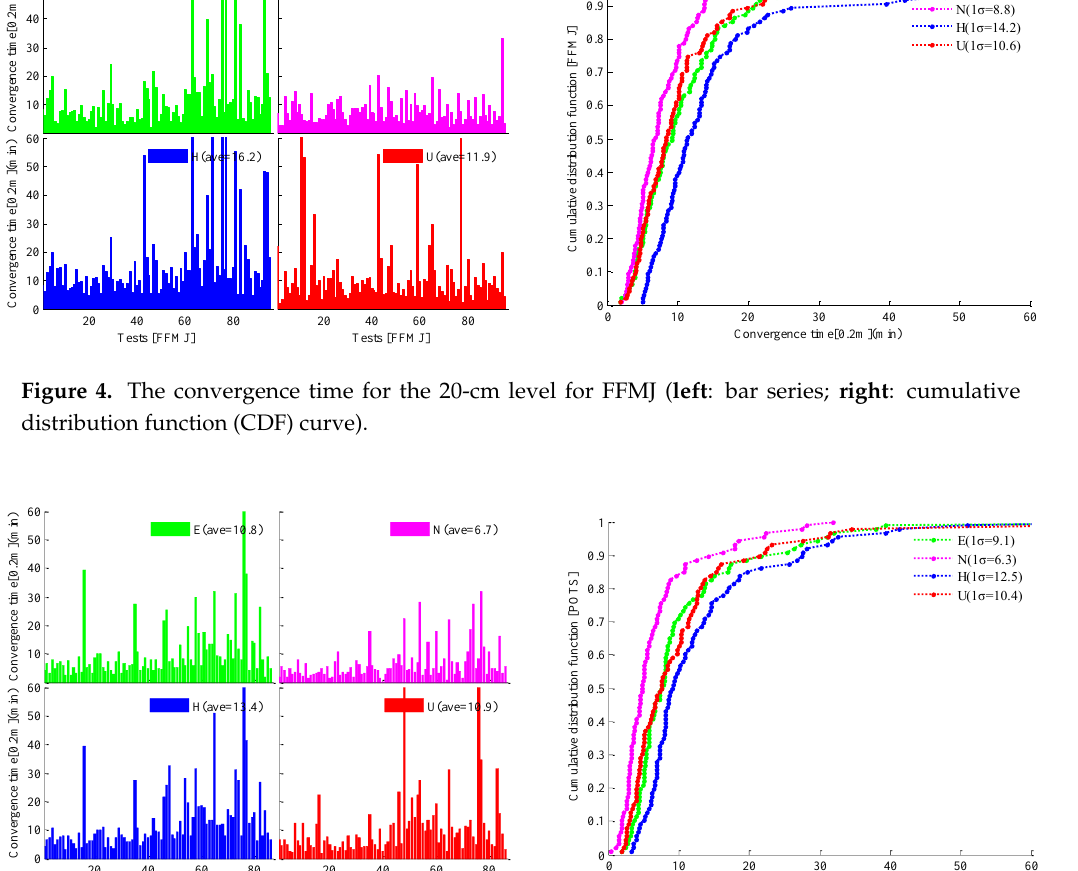
Figure 3. The error series of real-time simulated kinematic PPP in a time scale of 24 hours: ( 1 ) FFMJ; ( 2 ) POTS; ( 3 ) SIN1.